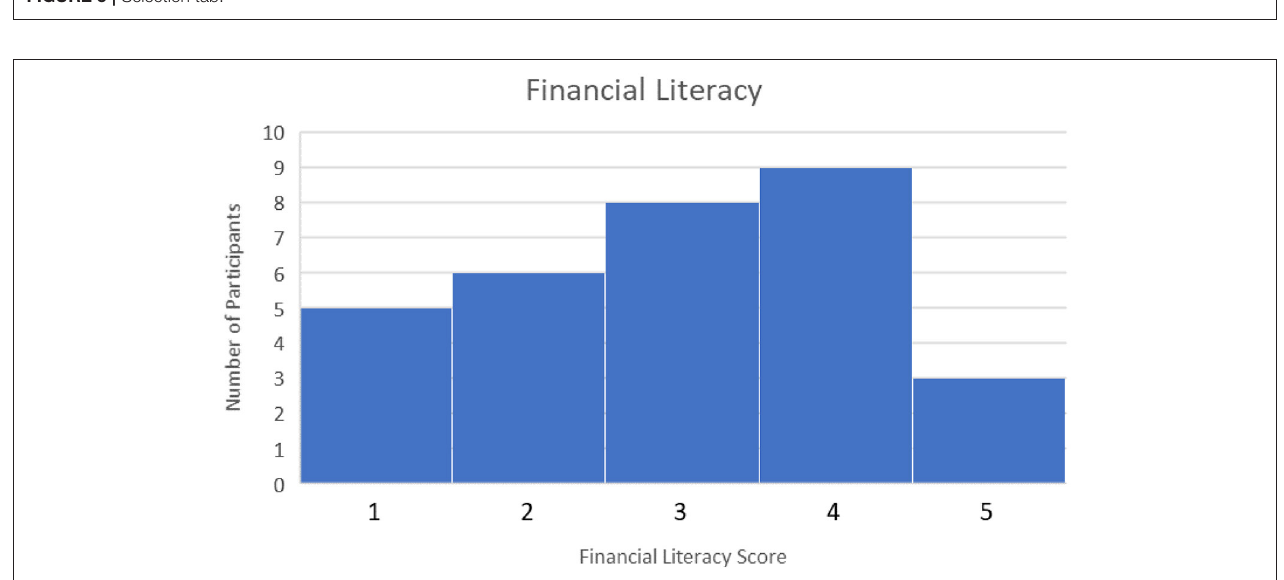
FIGURE 6 | Financial literacy